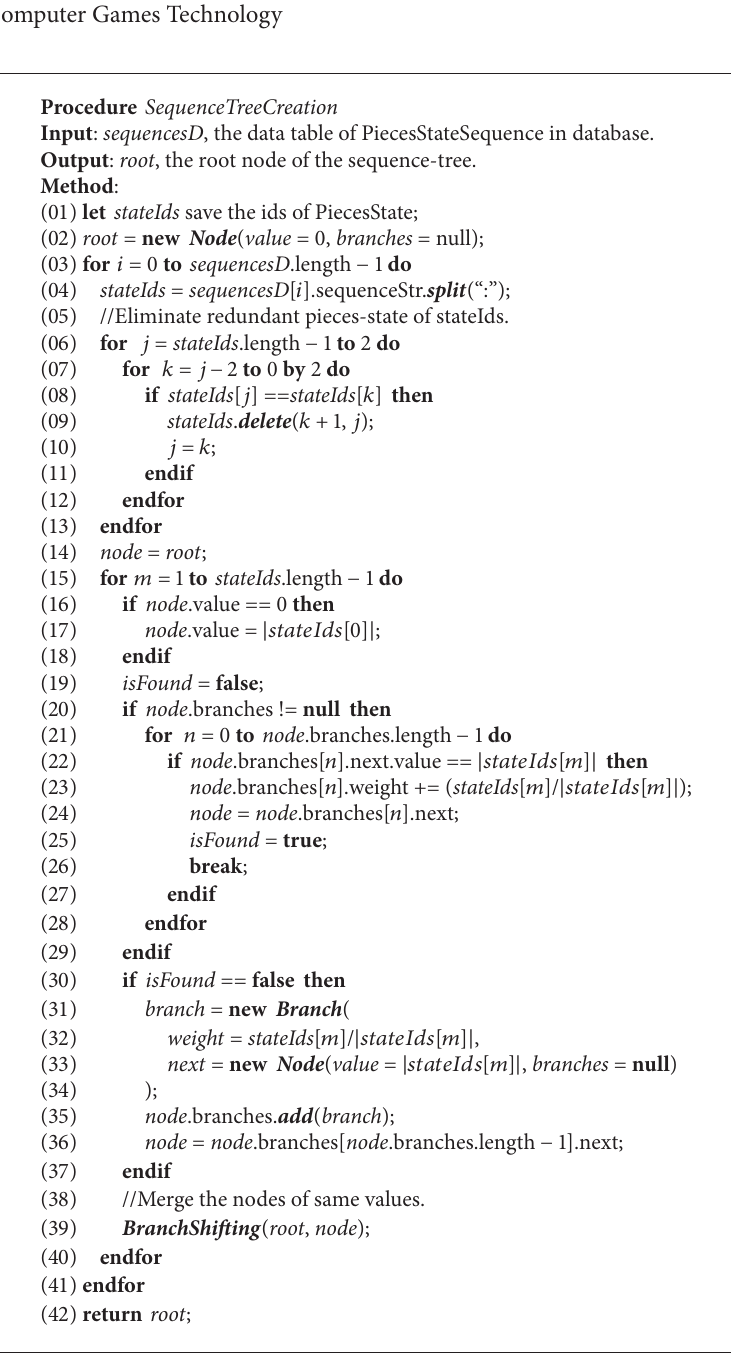
Algorithm 2: SequenceTreeCreation